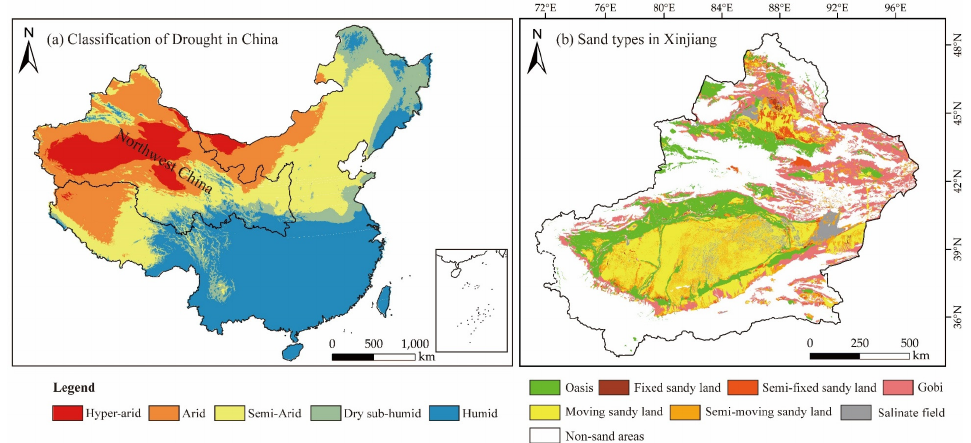
Figure 1. Overview of the study area. ( a ) The classification of drought in China. The degree of drought was classified based on the aridity index, which was divided into hyper-arid (<0.03), arid (0.03–0.2), semi-arid (0.2–0.5), dry sub-humid (0.5–0.65), and humid (>0.65) [47]. ( b ) The sandy types in Xinjiang. Data source: The Aridity index is calculated based on precipitation and evapotranspiration data obtained from TerraClimate [48]. Sand types data were obtained from the National Tibetan Plateau/Third Pole Environment Data Center